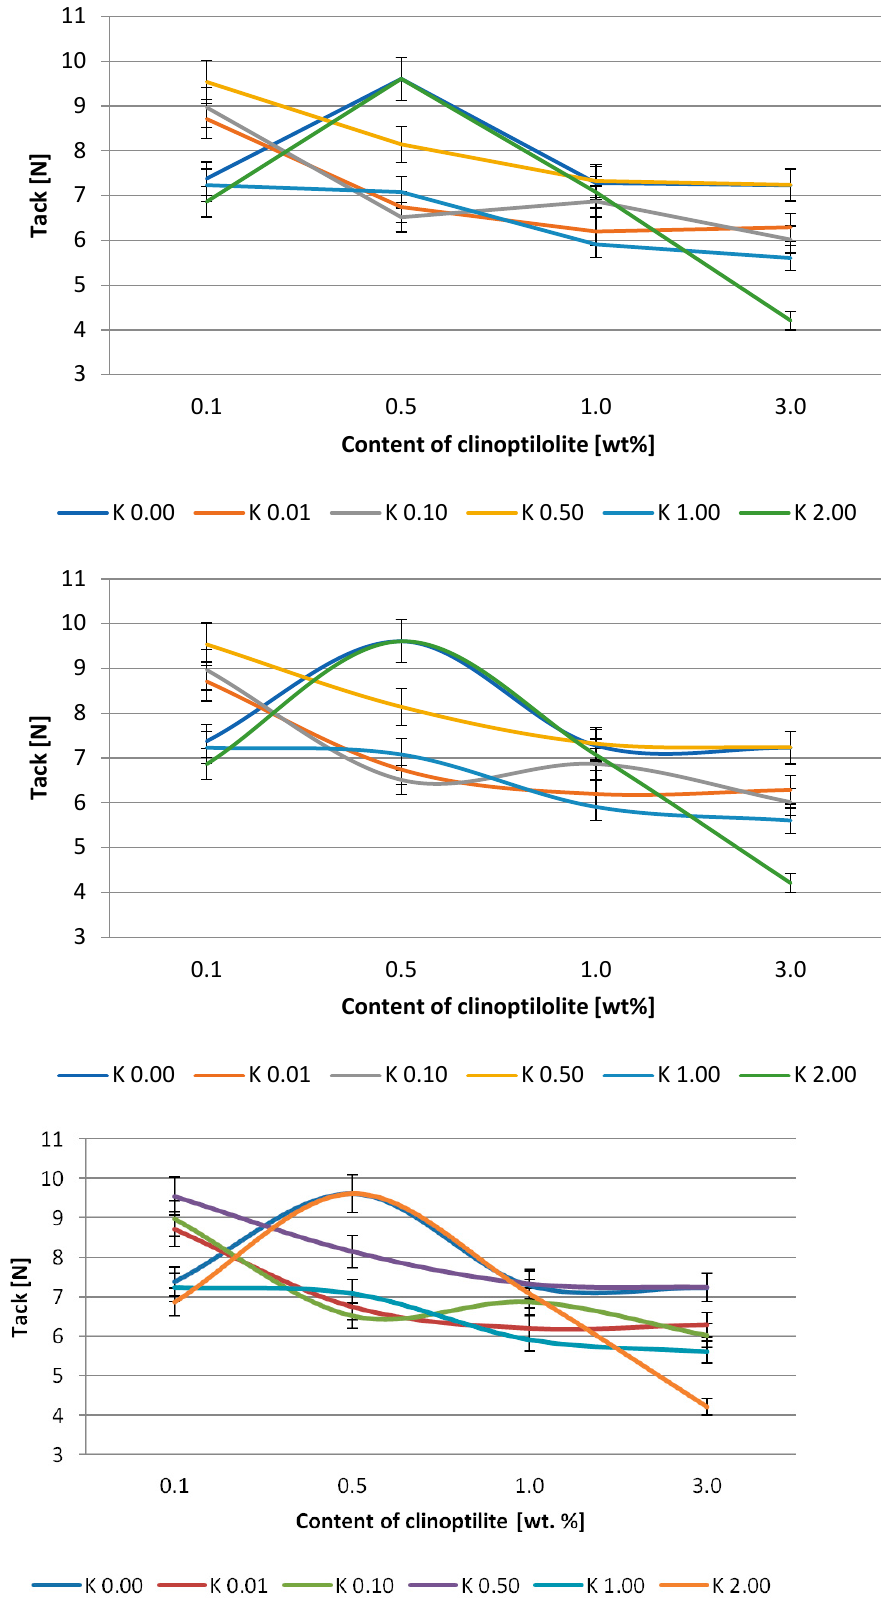
Figure 6. Effect of clinoptilolite content on the tack of silicone pressure-sensitive adhesives based on Q2-7355 resin.